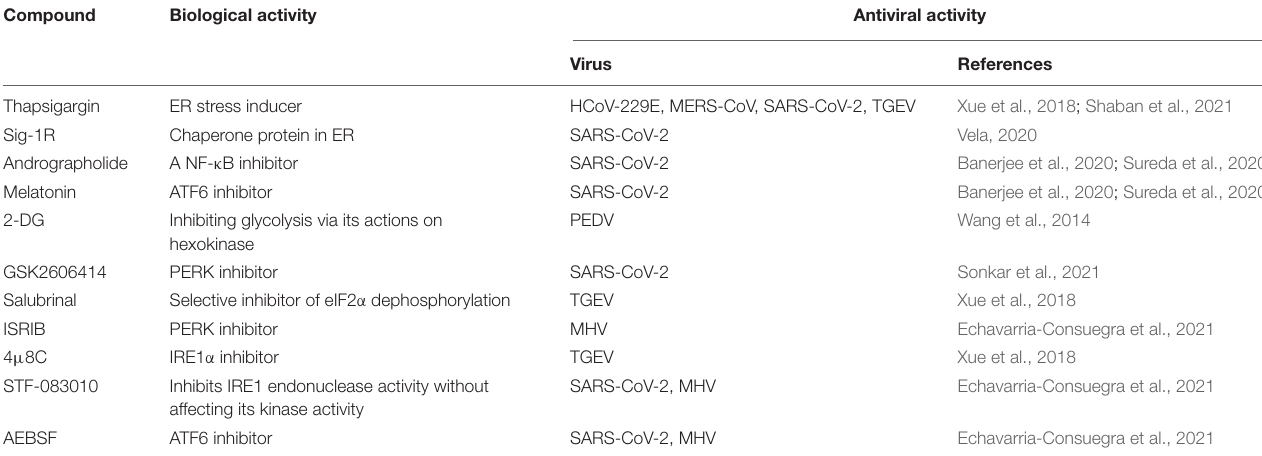
FIGURE 3 | Schematic representation of the interaction between ER stress, UPR, and innate immune system in response to coronavirus infection. (1) The PERK branch of UPR elicited by SARS-CoV 3a protein leads to ubiquitination, phosphorylation, and lysosomal degradation of IFNAR1 and inhibits IFN-I signaling. (2) TGEV infection activates the PERK-eIF2 α pathway, the phosphorylation of eIF2 α attenuates global protein synthesis, which decreases the levels of cytoplasm I κ B α and leads to reduced inhibition of I κ B α on NF- κ B, promoting IFN-I production. (3) The IRE1 axis reduced host miR-30a-5p abundance, resulting in increased negative feedback regulators of JAK-STAT signaling, SOCS1 and SOCS3. High expression of SOCS1 or SOCS3 disrupted the antiviral effect of IFN-I. The data explain that TGEV evades the IFN-I antiviral response despite the intense induction of endogenous IFN-I. TABLE 1 | A list of drugs that modulate ER stress and their anti-coronavirus